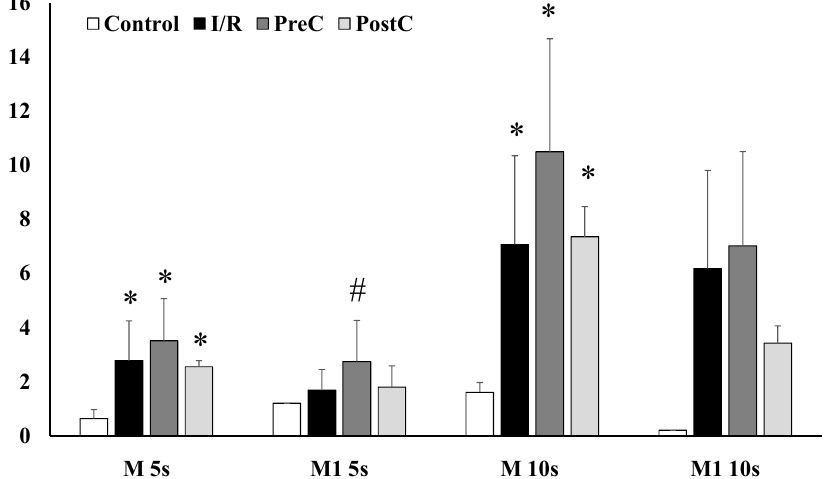
5s (only in PreC group: p = 0.038 vs. base and p = 0.046 vs. Control), as well as in M 10s ( p < 0.001 vs. base for both) and M1 10s index values ( p < 0.001 vs. base for both) (Figure 3).